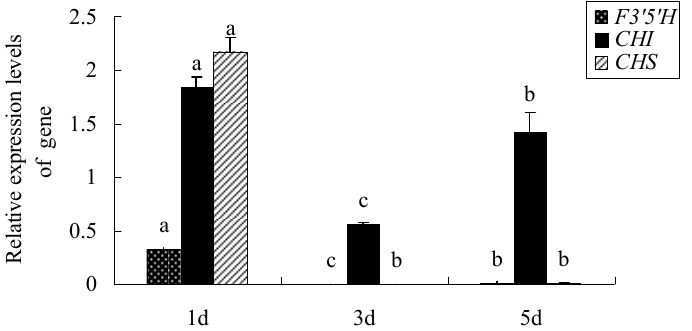
Figure 5. The expression levels of key genes of anthocyanin synthesis in different days. Values (mean ± SD) were determined from three independent experiments ( n = 3). Different letters above the bars indicate a significant difference at p < 0.05.